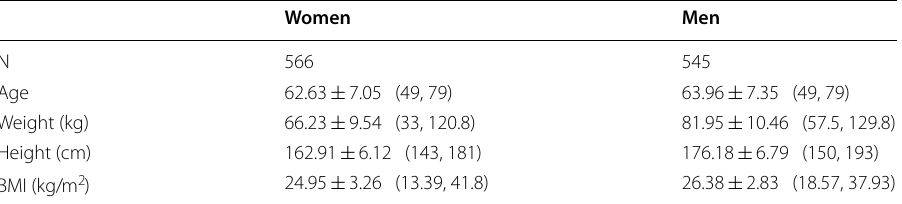
Table 1 Demographics and anthropometrics for participants from the UK Biobank imaging cohort used in model development and evaluation, separated by gender